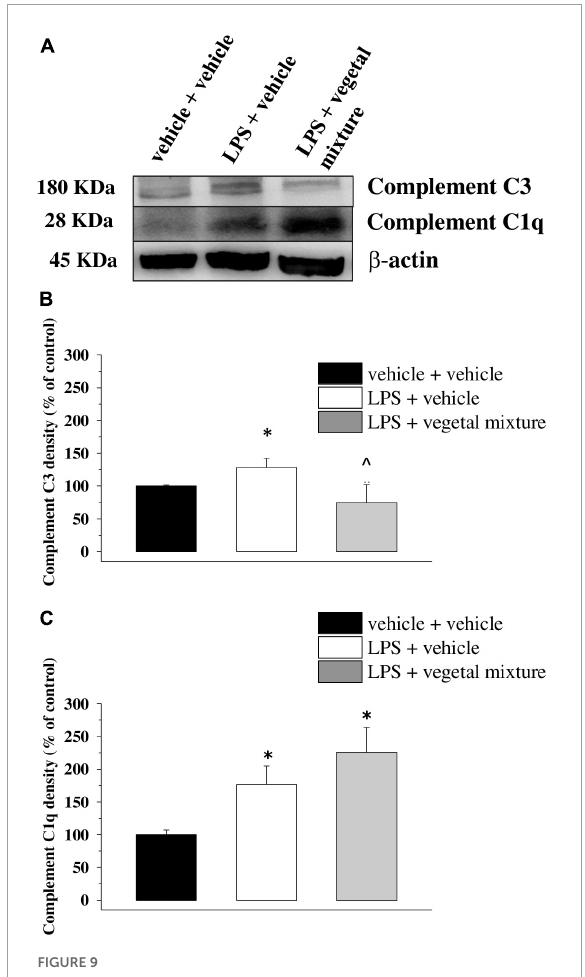
FIGURE9 Effect of a vegetal mixture on LPS-induced overproduction of complement components in the prefrontal cortex. The prefrontal cortex (PFC) lysates were analyzed for the density of the C1q and the C3 proteins. (A) Representative Western blot of the immunostainings for C3, C1q, and β -actin, in the PFC lysates of vehicle-treated, LPS-treated, and LPS + vegetal mixture-treated mice. The protein β -actin was used as an internal control. The blot is representative of the analysis of four animals for each experimental group. (B) Quantification of the change of C3 density in the PFC of vehicle-treated, LPS + vehicle, and LPS + vegetal mixture-treated mice. Results are calculated as C3 ÷ β -actin ratio and are expressed as a percentage of the respective ratio in vehicle-treated mice. (C) Quantification of the change of C1q density in the PFC of mice as above. Data are expressed as mean ± SEM of eight mice analyzed in two different experimental sets. ∗ p < 0.05 vs. vehicle-treated mice; ∧ p < 0.05 vs. LPS-treated